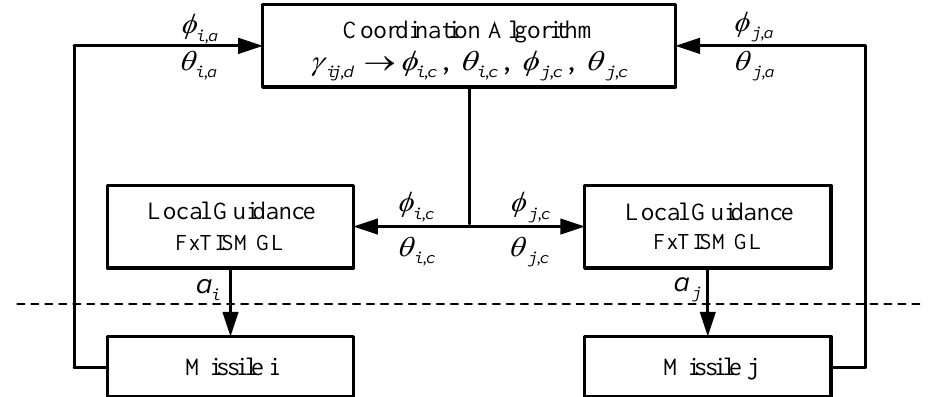
Figure 3. Two-level dynamic cooperative guidance architecture for relative geometry